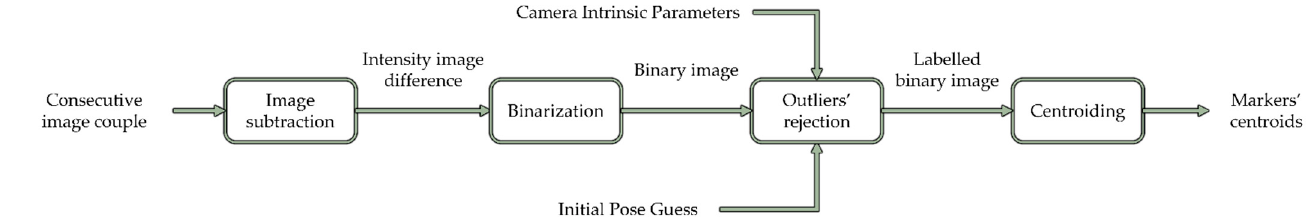
Figure 5. Flow chart for the detection step proposed for the pose estimation algorithm employing images from the chaser-fixed camera.